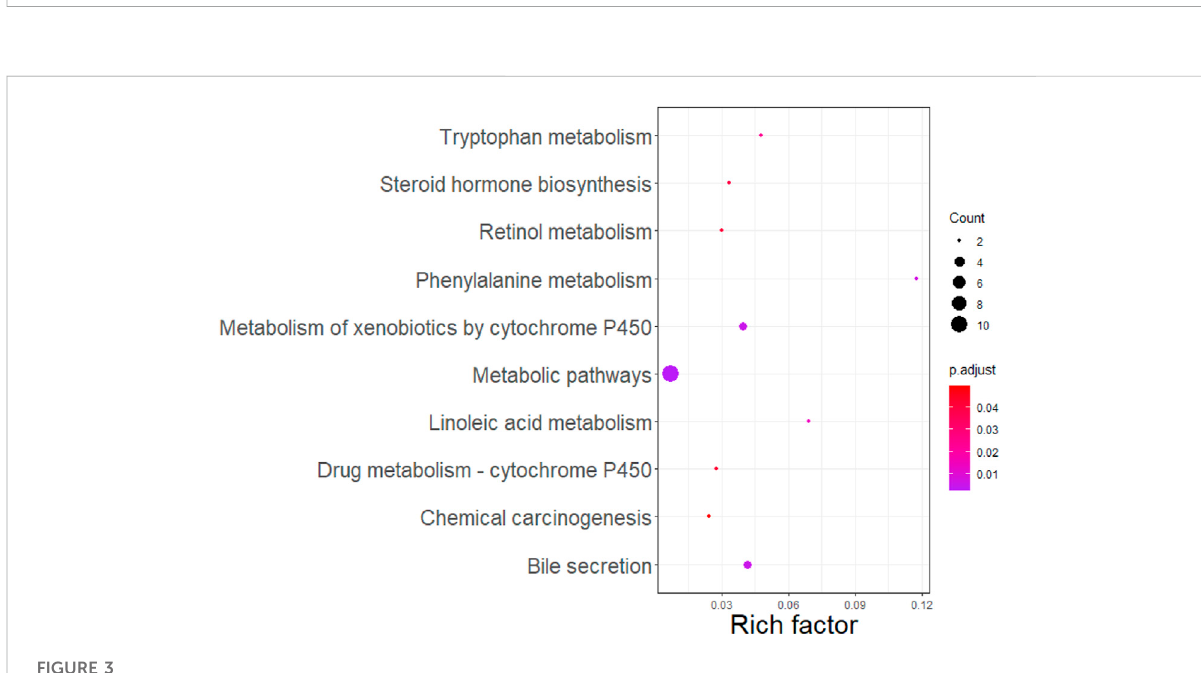
FIGURE 3 KEGG enrichment analysis for 56 genes